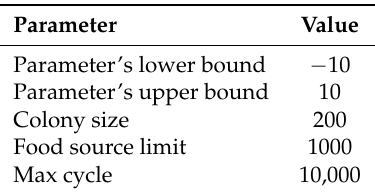
Table 3. Artificial bee colony (ABC) algorithm parameters.